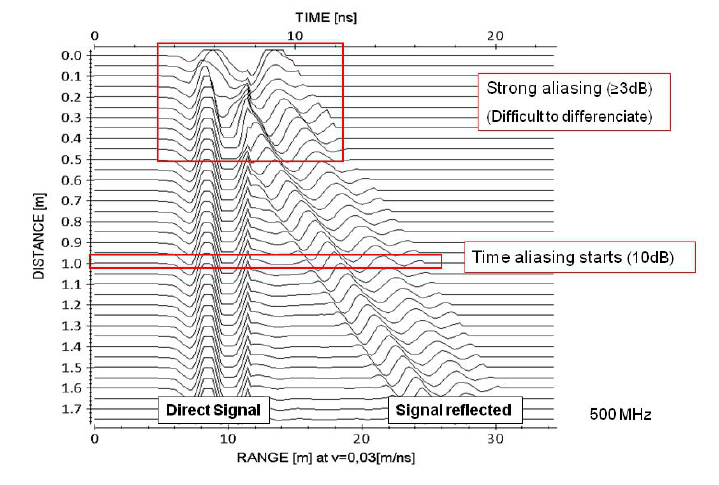
Figure 7. Obtained radargram where it is possible to observe the recorded wavelet after its reflection in the metallic bar at different distances.